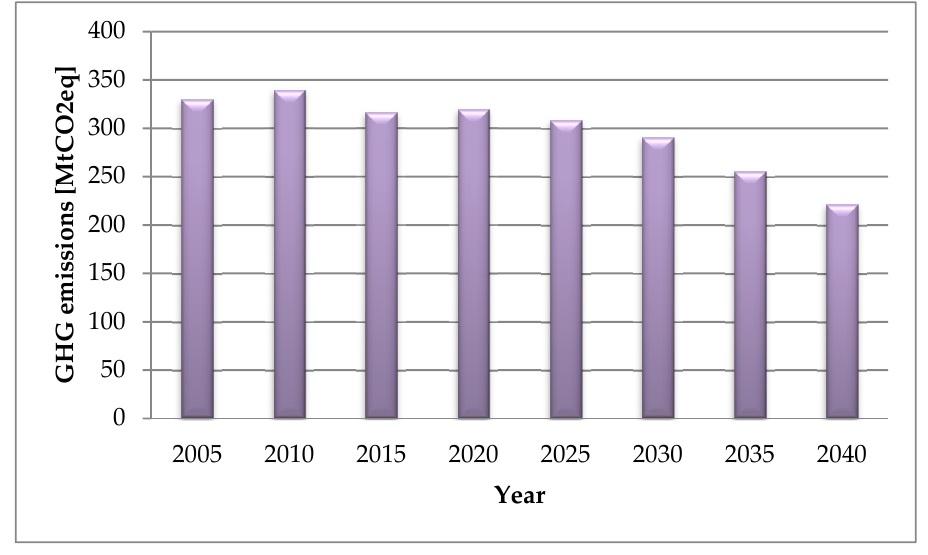
Figure 2. Greenhouse gas emissions from the energy sector, Mt CO 2eq (own work based on Reference [47]).